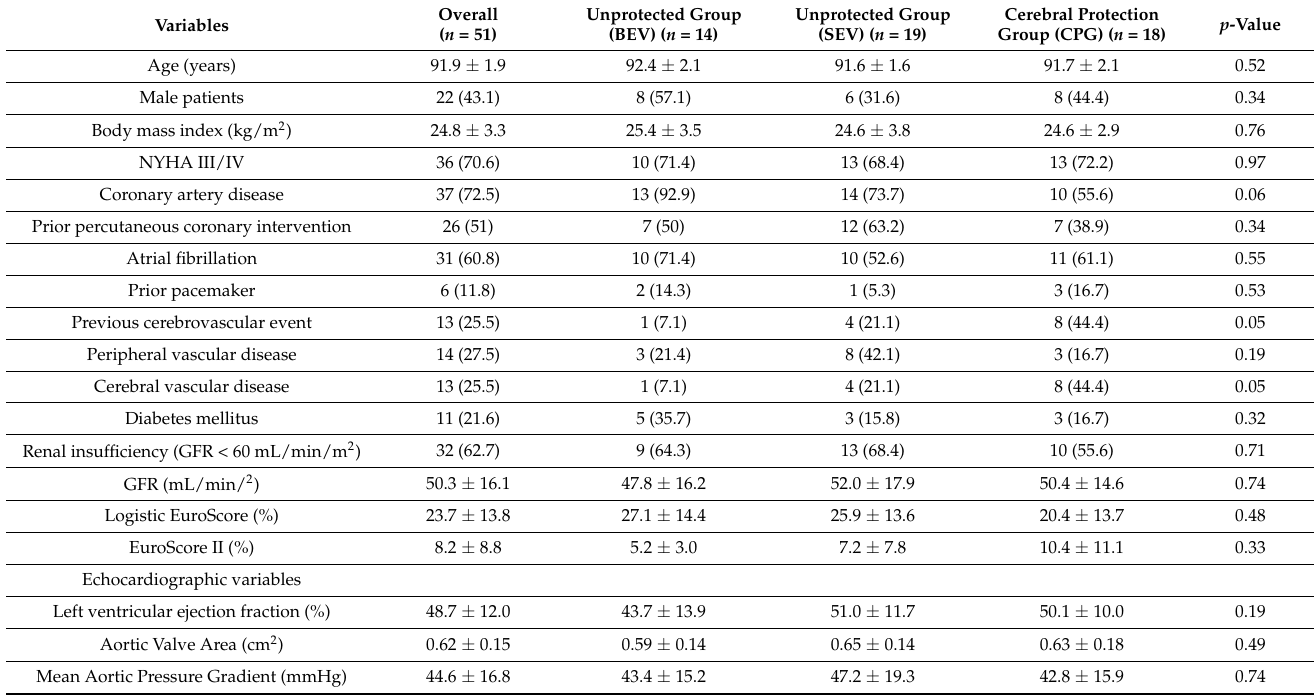
Table 1. Baseline characteristics of the study